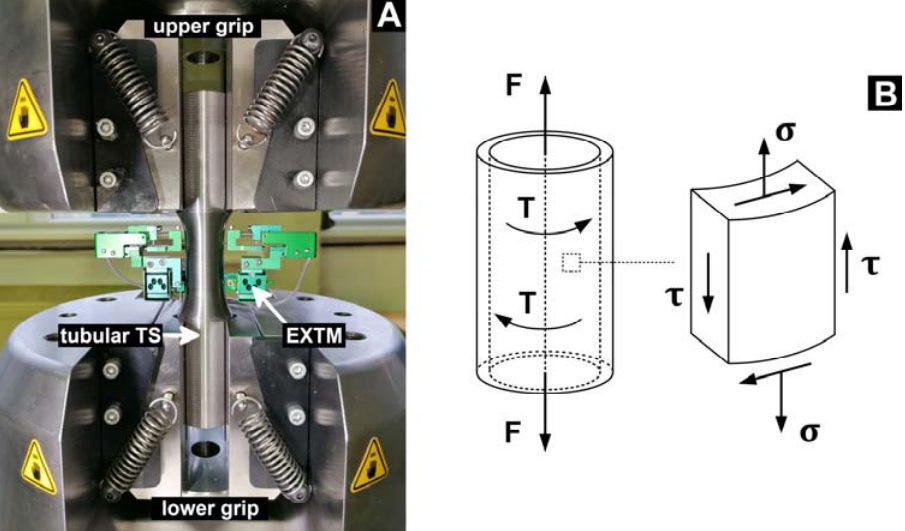
Figure 2. Experimental setup ( A ): a thin-walled tubular specimen clamped in hydraulic grips of the testing machine, and a contact biaxial extensometer is attached in four points on the reduced section of the TS. Stress state representation ( B ) within the TS subject to combined axial load and torque.